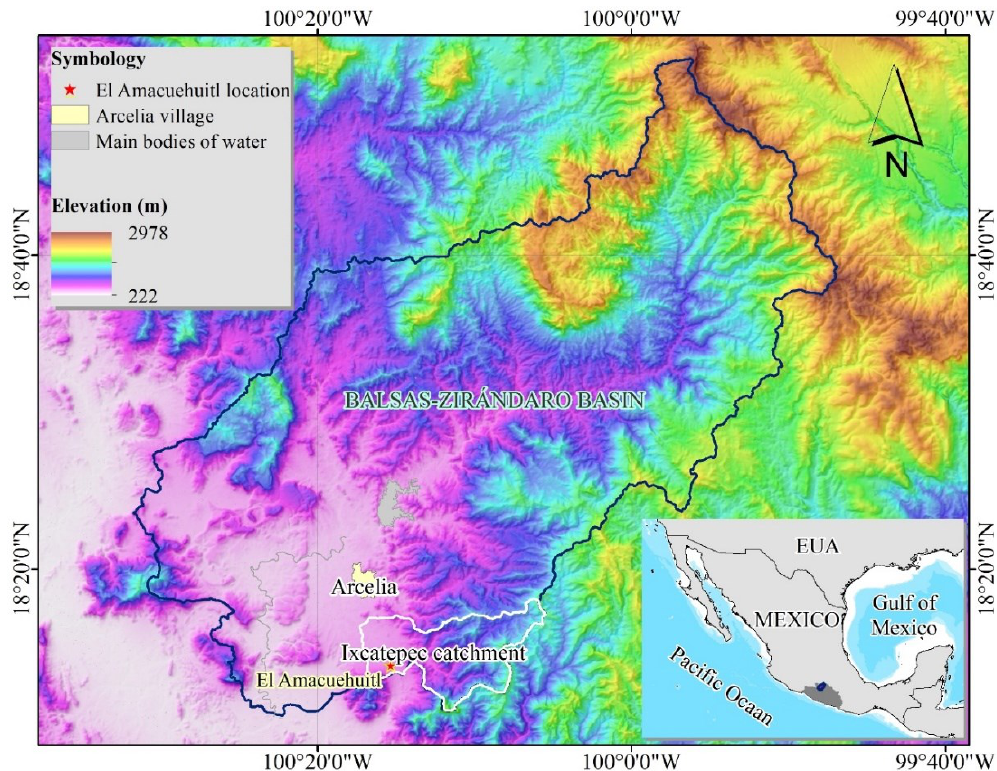
Figure 1. Topographic map of the study area based on the digital elevation model (Data sources: https://srtm.csi.cgiar.org/ (accessed on 15 November 2021) [31].